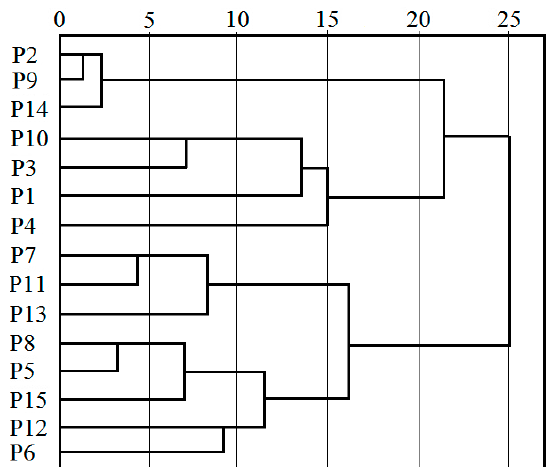
Figure 8. Tree map of soil salinity clustering analysis. Table 3. Statistical characteristics of soil salinity at different depths.